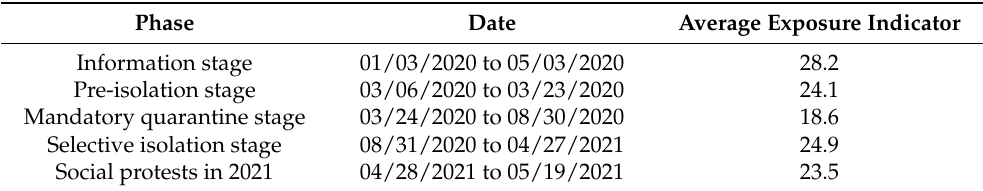
Table 1. Detailed information on the exposure ratio and its relation to relevant periods for the period under